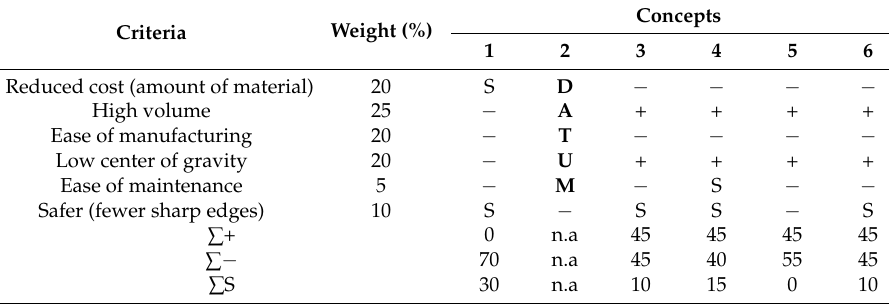
Table 2. Second-round decision matrix for tank design selection.